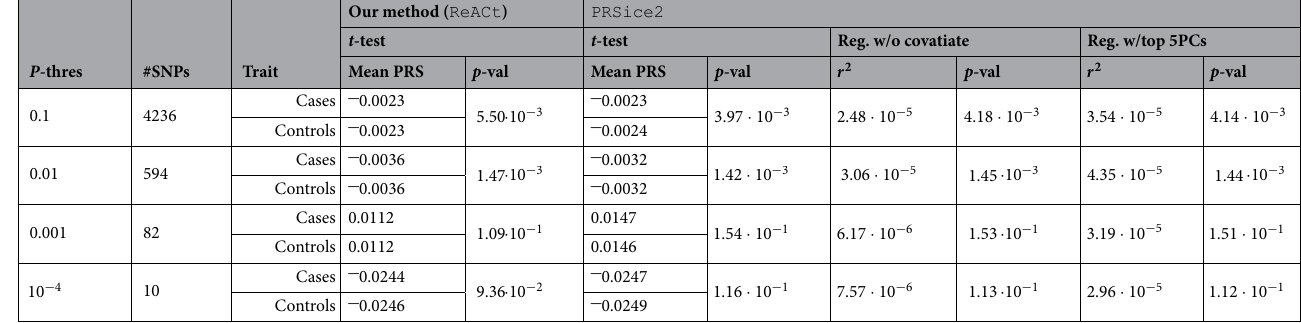
Table 6. Estimated and real group mean and standard deviation of PRS for depressive episode cases and controls in UK biobank population. We assessed the performance of our method using the summary statistics of an independent MDD GWAS as the base study, and the UK biobank samples, including 18,368 cases with depressive episode and 312,849 controls, as the target population. We generated summary statistics for the target populations and estimated group mean PRS and standard deviation of target PRS using ReACt. We computed the individual level PRS for the target study using PRSice2. For both methods, we computed PRS using independent SNPs from the base summary statistics with p -values below various thresholds ( P -thres) and compared the performances under each threshold. For ReACt, mean PRS represents the estimated group mean PRS for cases and controls; p -val are the t -test p -values comparing PRS distribution in cases and in controls. For PRSice2, mean PRS represents real group mean PRS computed from individual level data and p - val are the t -test p -values comparing real PRS distribution in cases and in controls; reg. w/o covariate indicates 2 2 regression results without covariates, which include the regression r value (reg. r ) and the p -value for the PRS predictor ( p -val); reg. w/top 5PCs indicates the regression results including the top five PCs as covariates, 2 2 which also included the regression r value (reg. r ) and the p -value for the PRS predictor ( p